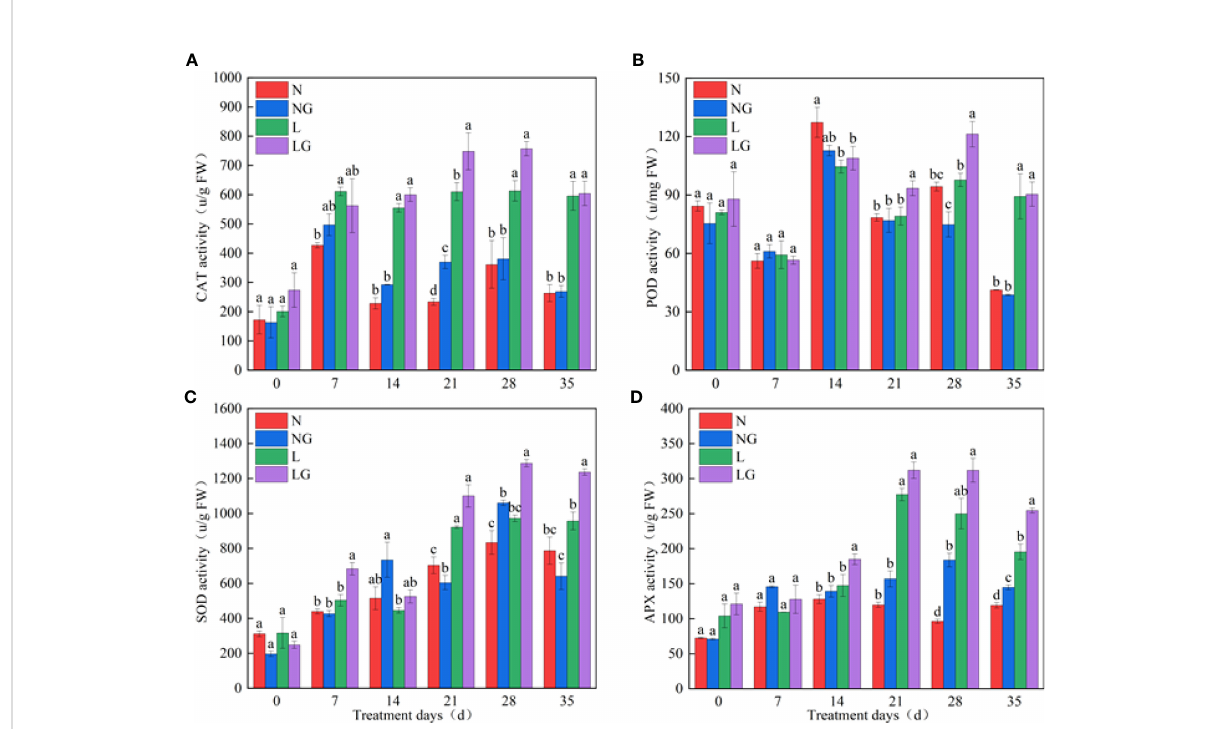
FIGURE 4 Effect of GABA spraying on antioxidant enzyme activity in M. ruthenica seedlings on different treatment days. (A) Catalase (CAT) activity in leaves; (B) peroxidase (POD) activity in leaves; (C) superoxide dismutase (SOD) activity in leaves; (D) ascorbate peroxidase (APX) activity in leaves. N, the plant pretreated with distilled water and grown at normal temperature. NG, the plant pretreated with GABA and grown at normal temperature. L, the plant pretreated with distilled water and grown at low temperature. LG, the plant pretreated with GABA and grown at low temperature. Different lowercase letters indicate signi fi cant differences between N, NG, L, and LG on the same treatment day ( P < 0.05).